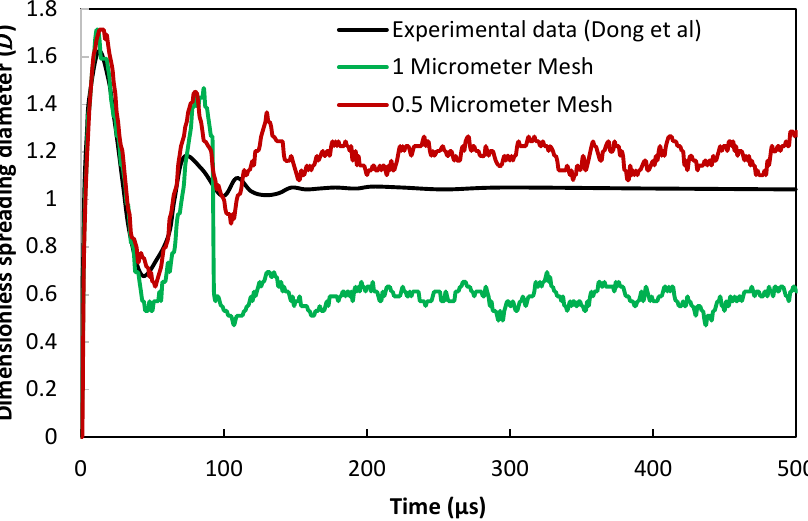
Figure 3. Dimensionless spreading diameter: simulation compared with experimental measurement [15].